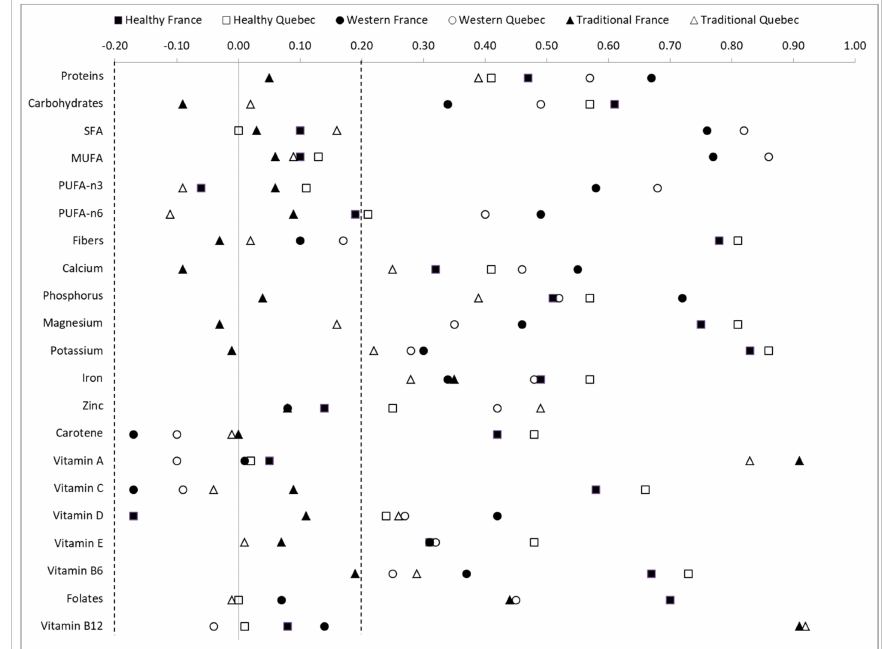
Figure 1. Comparison of the factor loadings from the nutrient patterns obtained in the 3C and NuAge cohorts. SFA: Saturated fatty acids, MUFA: Monounsaturated fatty acids, PUFA: Polyunsaturated fatty acids. Doted lines represent the cut-o ff values for the interpretability of factor loadings (0.20 in absolute